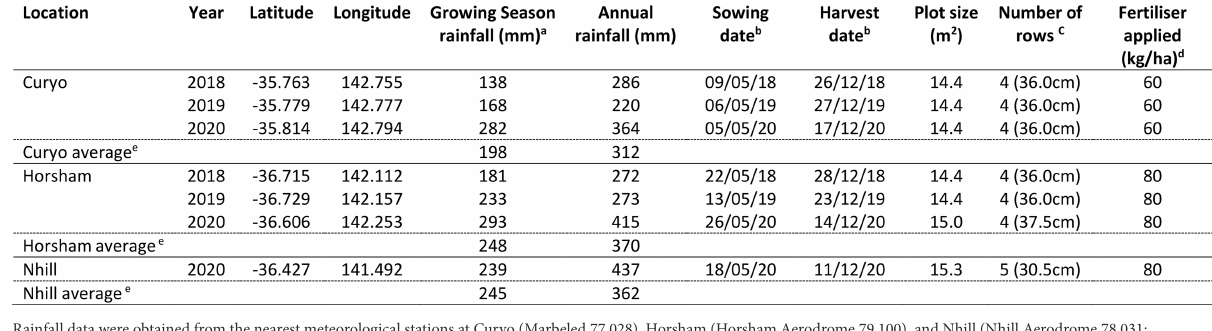
Rainfall data were obtained from the nearest meteorological stations at Curyo (Marbeled 77,028), Horsham (Horsham Aerodrome 79,100), and Nhill (Nhill Aerodrome 78,031; Queensland Government, 2022). a Growing Season rainfall is between April and October. b Day/Month/Year. c The number of rows (tynes on seeder) sown in each plot and their spacing. d Mono-Ammonium Phosphate (MAP; Nitrogen: Phosphorus: Potassium: Sulphur: Zinc at 9.2:20.2:0:2.7:2.5). e 20-year average from 2001 to